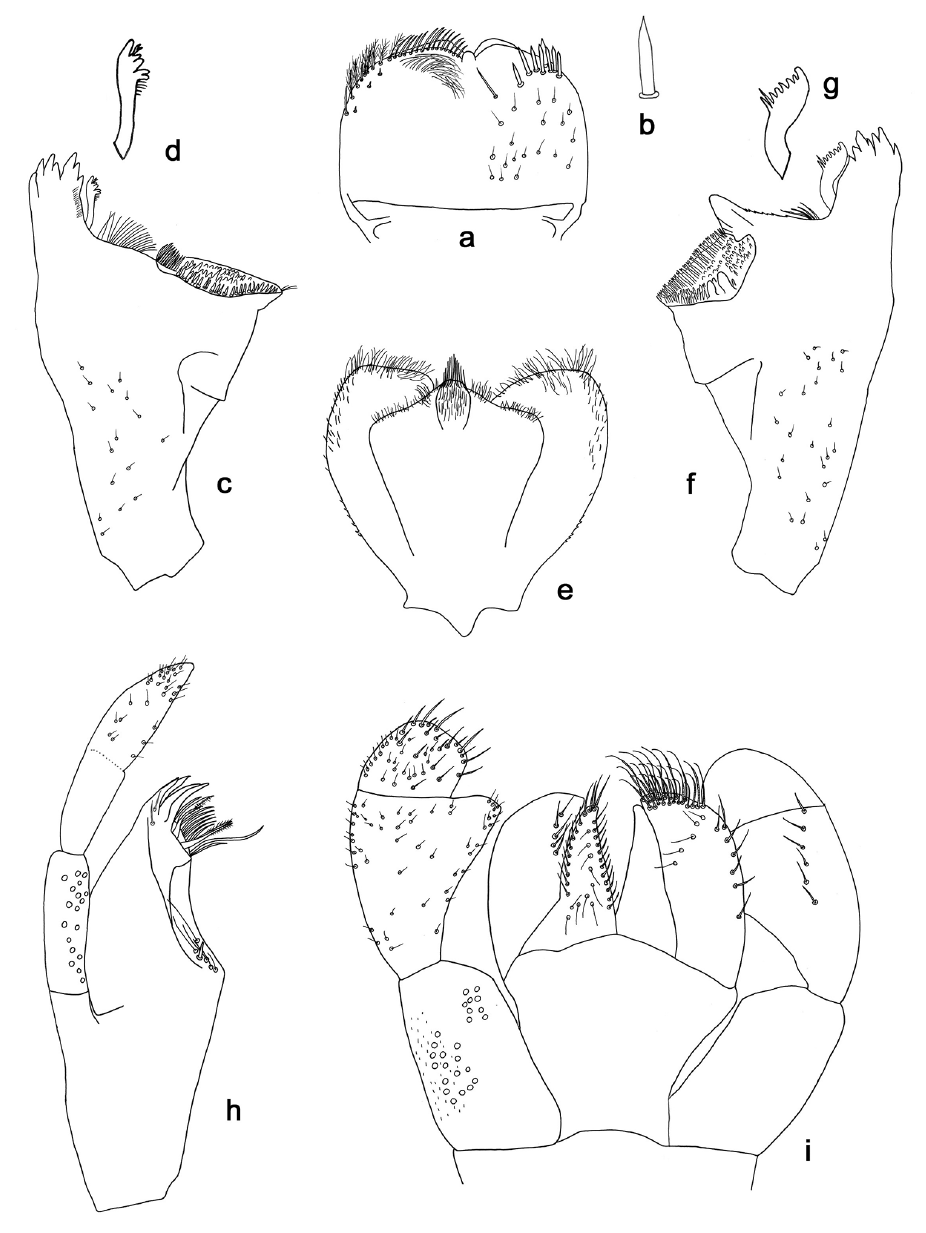
Figure 2. Indocloeon spathasetis sp. n., larva morphology: a Labrum b Seta of the labrum dorsal submarginal arc c Right mandible d Right prostheca e Hypopharynx f Left mandible g Left prostheca h Maxilla i Labium. Prostheca robust, apically denticulate (Fig. 2d). Margin between prostheca and mola straight, tuft of setae present. Tuft of spine-like setae at base of mola absent. Tuft of setae at apex of mola